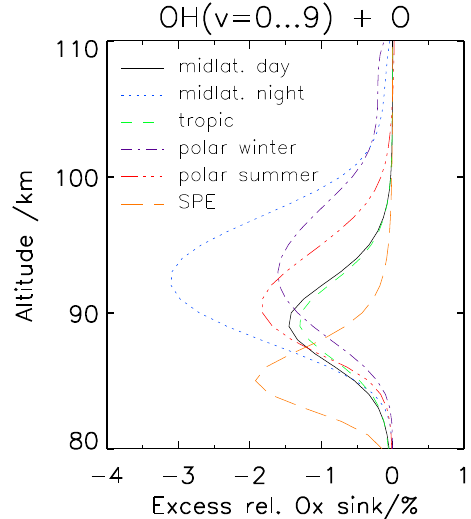
Fig. 11. Excess relative O x sink by consideration of vibrationally excited OH in the OH+O reaction as a function of altitude for vari- ous atmospheres.